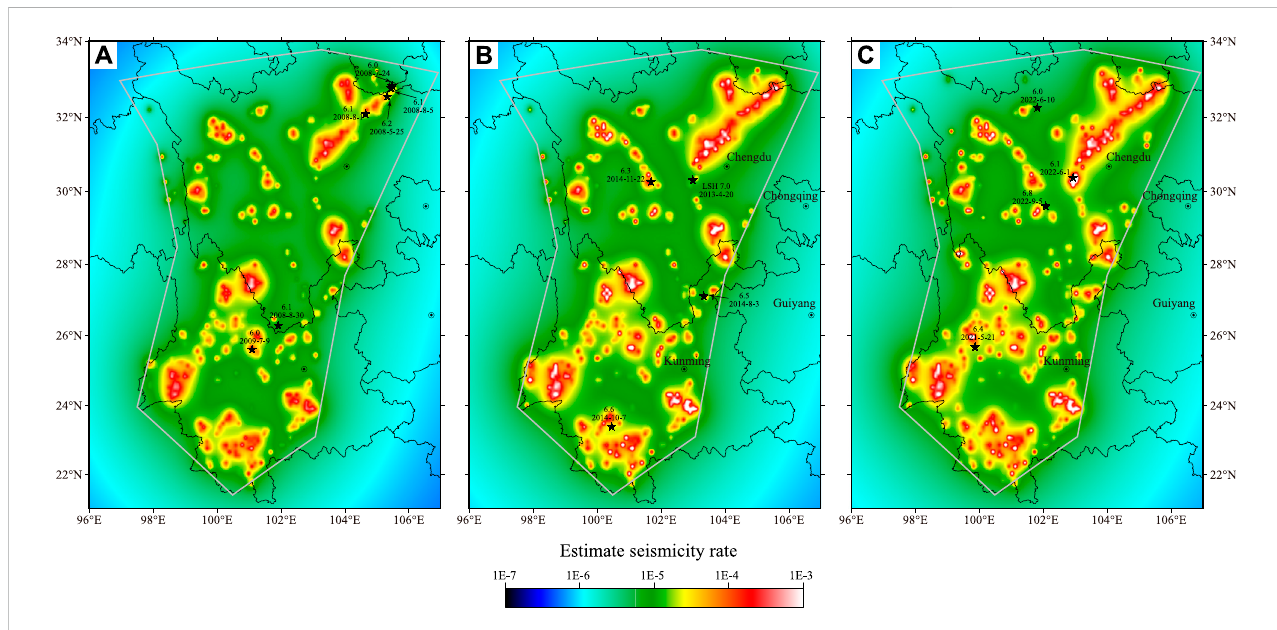
FIGURE 3 Estimated seismicity rate using earthquakes based on the China Earthquake Networks Center (CENC) catalog. The learning period was from January 1, 1970, to January 1, 1990, based on the proximity-to-past-earthquakes (PPE) model to calculate the conditional density. (A – C) Estimated results using data before May 20, 2008; January 1, 2013; and September 10, 2019, respectively. The black stars indicate the target earthquakes. The gray line encloses the test area in the Sichuan-Yunnan region.